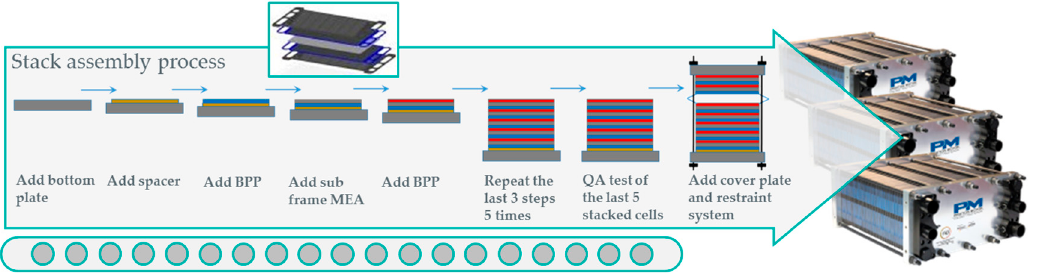
Figure 6. Schematic of the stack assembly process.